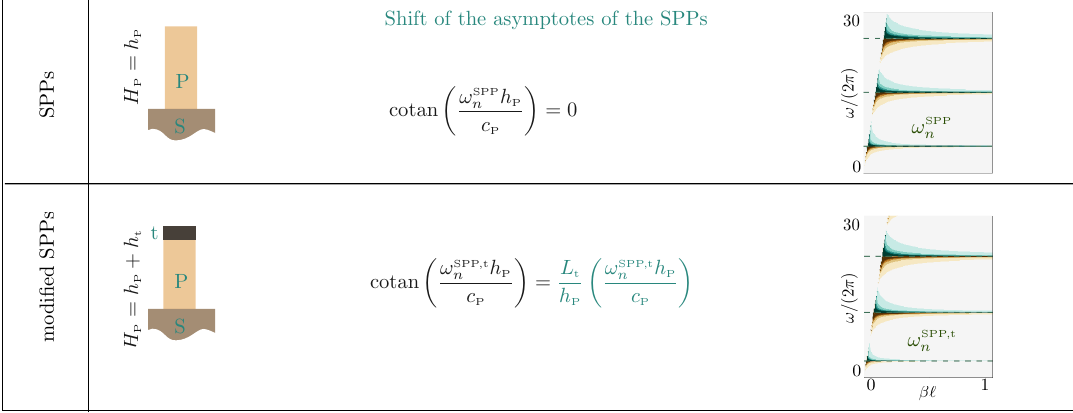
Figure 6. Asymptotes of the SPPs (at ω SPP n / ( 2 π ) = 3,15,25) and modified SPPs (at ω SPP,t n / ( 2 π ) =